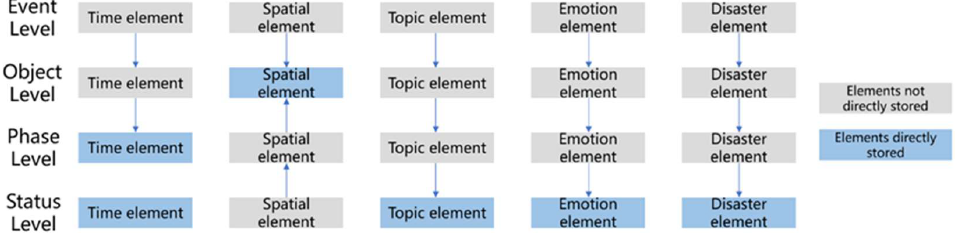
Figure 4. Schematic diagram of the method for obtaining element information in four levels.